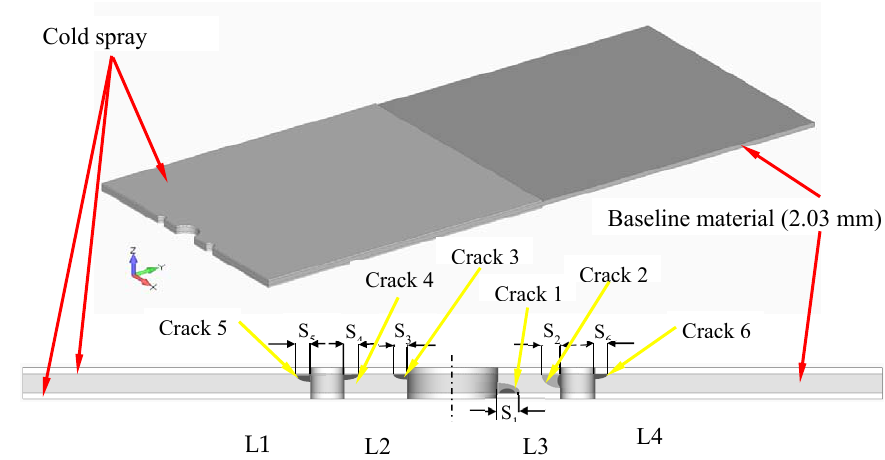
Figure 20. Schematic of ½ of a dome nut fastener hole specimen (DNHS) coupon with a 0.453 mm-thick cold spray repair on either side of the test specimen; from [46].